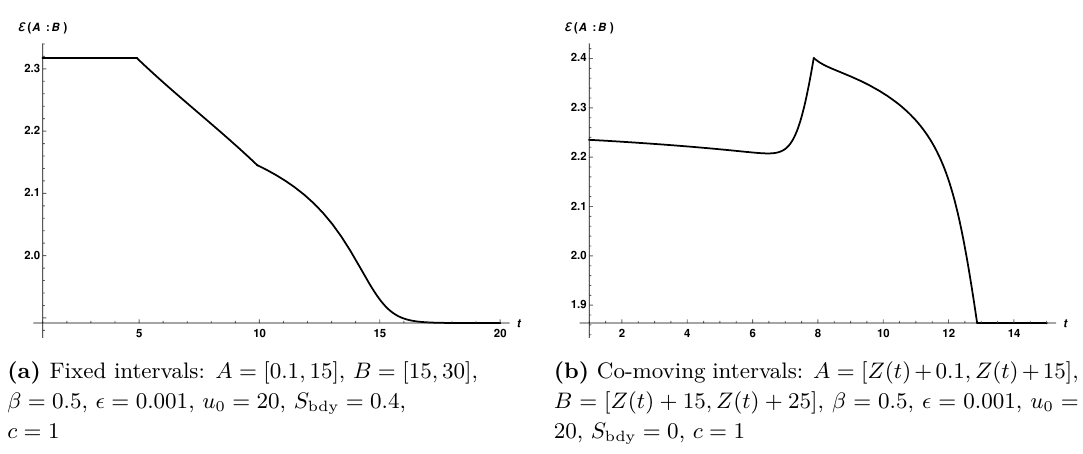
Figure 27. Adjacent intervals. Page curve for the entanglement negativity between two adjacent intervals in an escaping mirror BCFT.